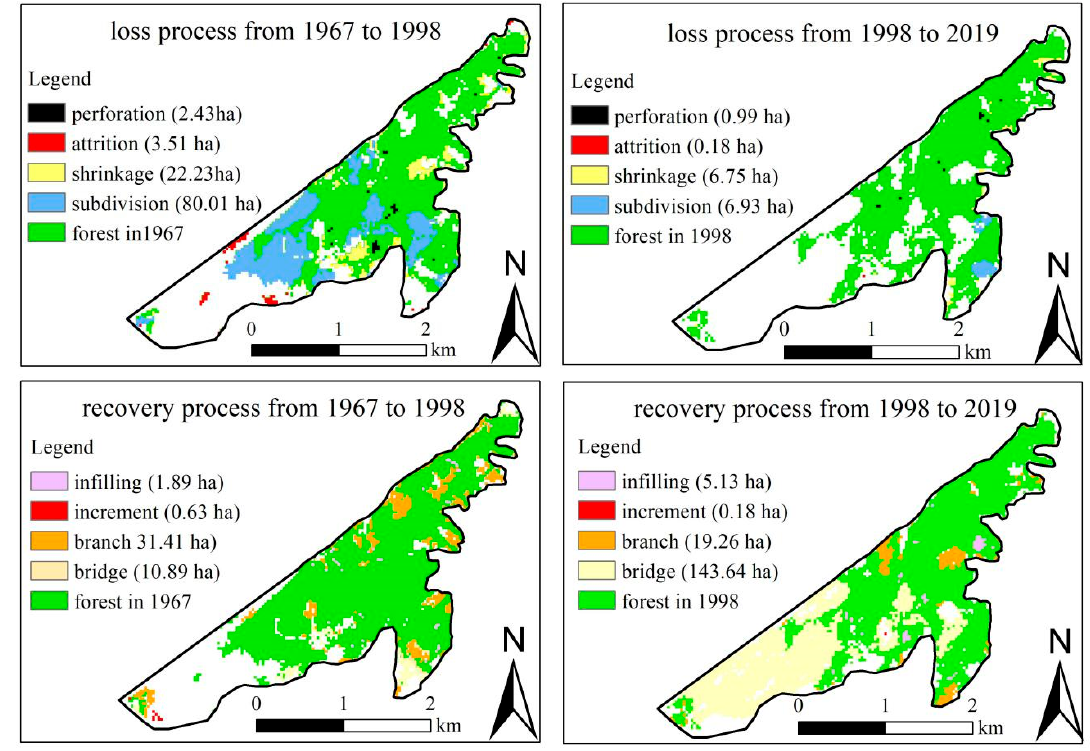
Figure 8. Spatial process map of forest loss and restoration.